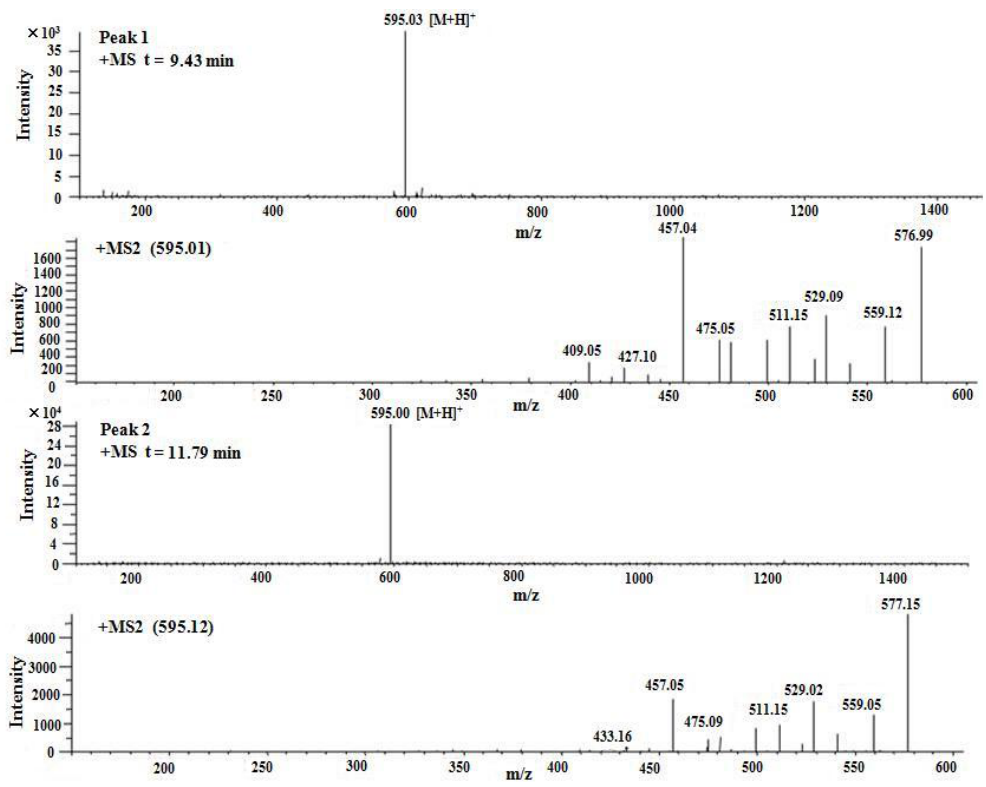
Figure 6. Positive ion ESI mass spectra and MS n spectra of peak 1, 2, 4, 3,